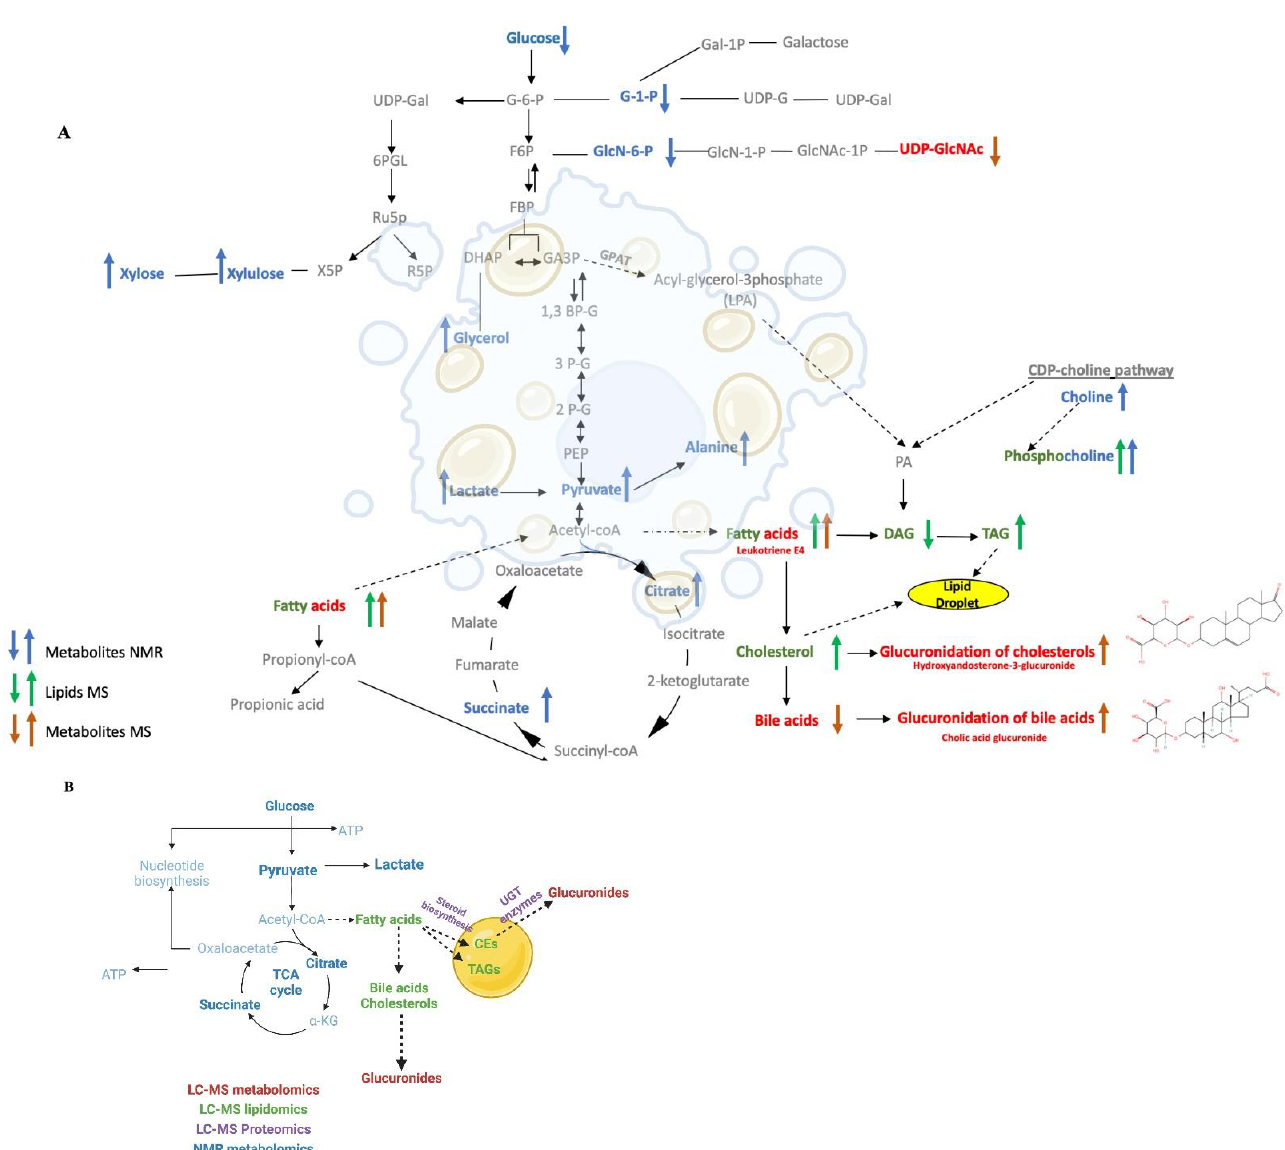
Figure 7. ( A ) A schematic diagram of the metabolic and lipidomic network created from the integrated metabolomics and lipidomics data sets. The network map summarizes the consensus changes in the hepatocyte lipidome (green), NMR detected metabolome (blue), and LC-MS detected metabolome (red) resulting from ethanol exposure. An up arrow indicates a relative increase and a down arrow indicates a relative decrease due to ethanol exposure. ( B ) A summary network map combining the outcomes from the lipidomics, metabolomics and proteomics data set. The network map summarizes the consensus changes in the lipid drop proteins (purple), and the hepatocyte lipids (green), NMR detected metabolome (blue), and LC-MS detected metabolome (red) resulting from ethanol exposure. A metabolomics and lipid network map (Figure 7A) was created by manually curating the statistically significant metabolites (MS, red; NMR, blue) and lipids (green) with an observed enrichment analysis (FDR-corrected p < 0.05) and adding them to a standard set of metabolic pathways that was then plotted with the Biorender application [47].